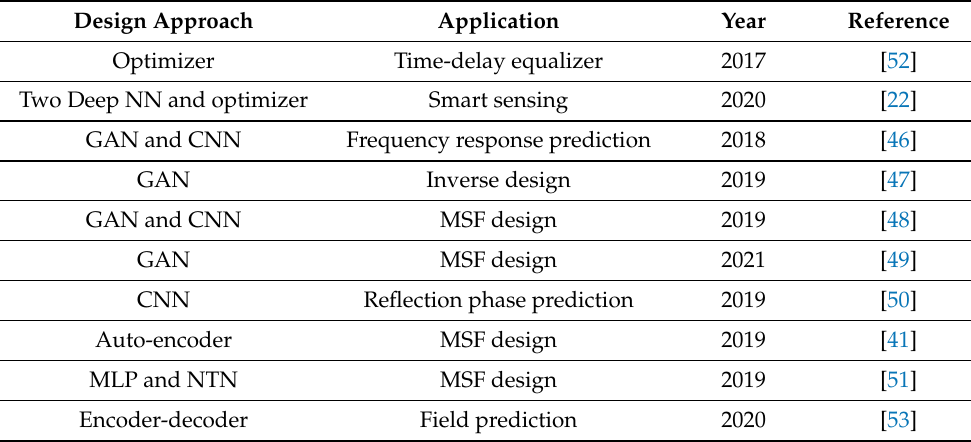
Table 2. Summarizing the state of the art data-driven approaches. Design Approach Application Optimizer Two Deep NN and